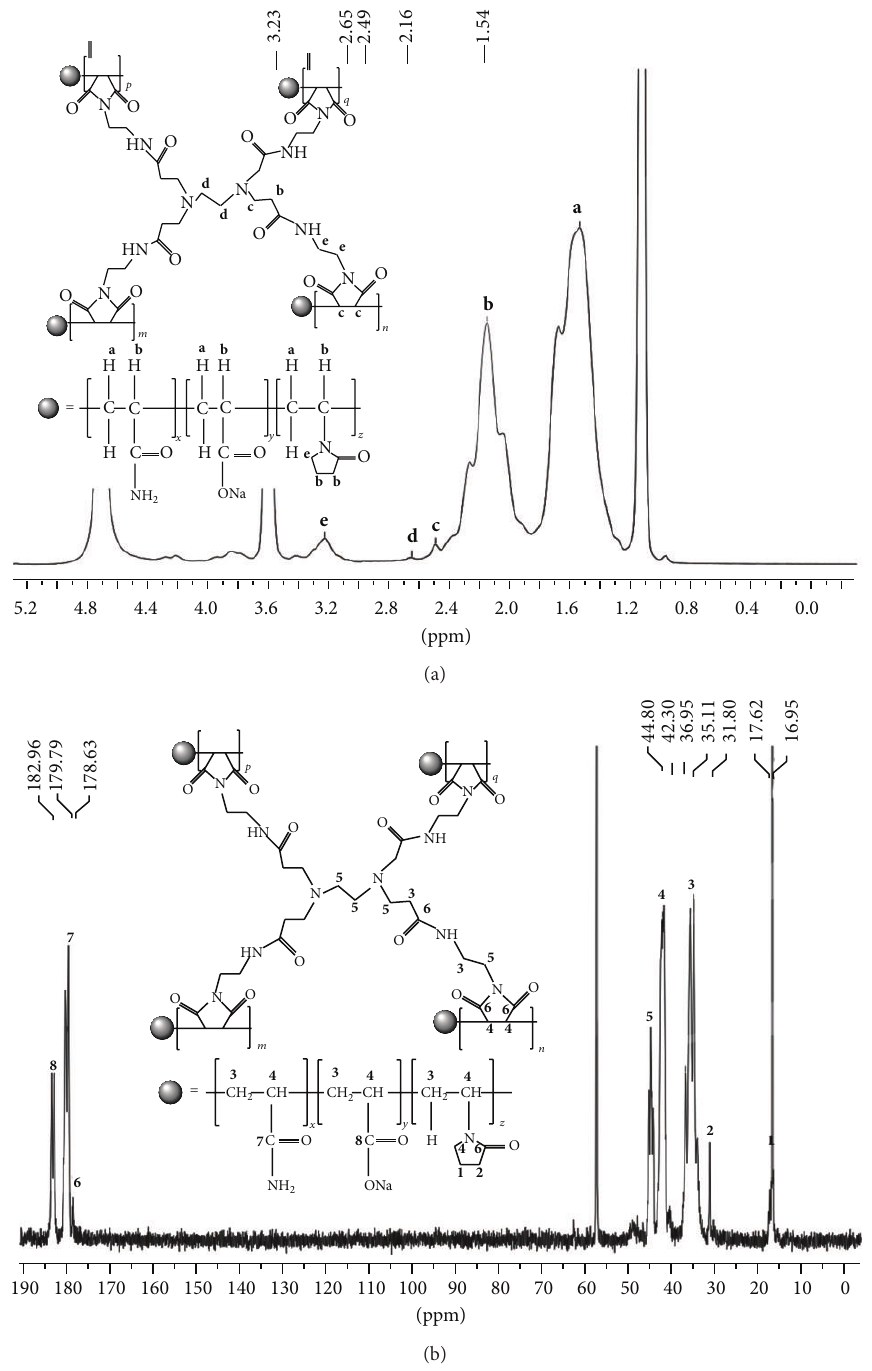
Figure 4: (a) 1 H NMR spectrum of the hyperbranched polymer in D 2 O; (b) 13 C NMR spectrum of the hyperbranched polymer in D 2 O.